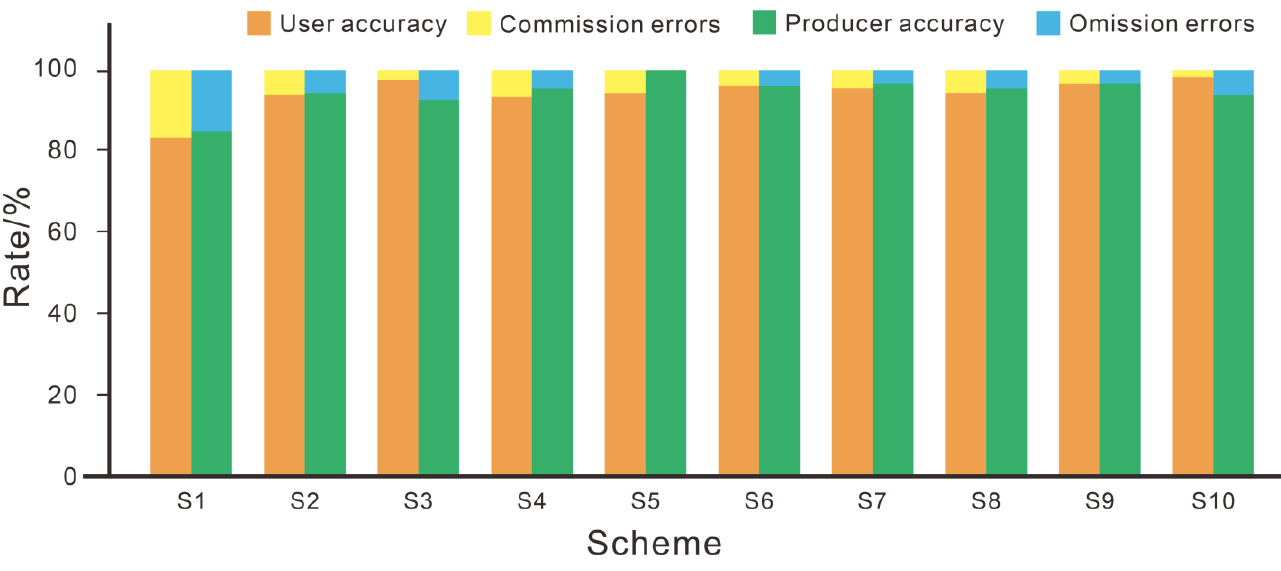
Figure 10. UA and PA of COTC extraction in different